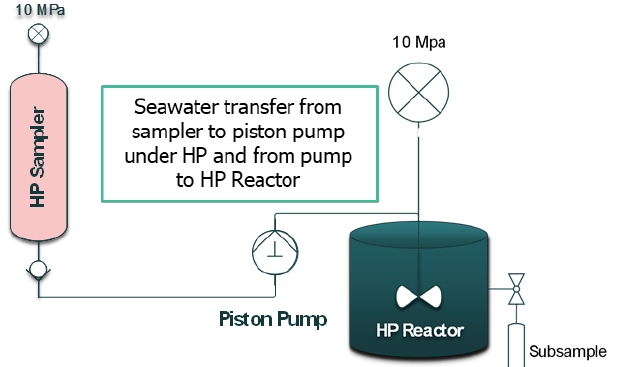
Figure 3. Schematic representation of the deep-sea water transfer from the HP-sampler to HP-Reactor in the lab.